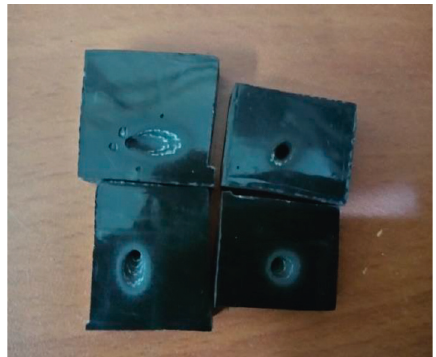
Figure 3: Samples after erosion